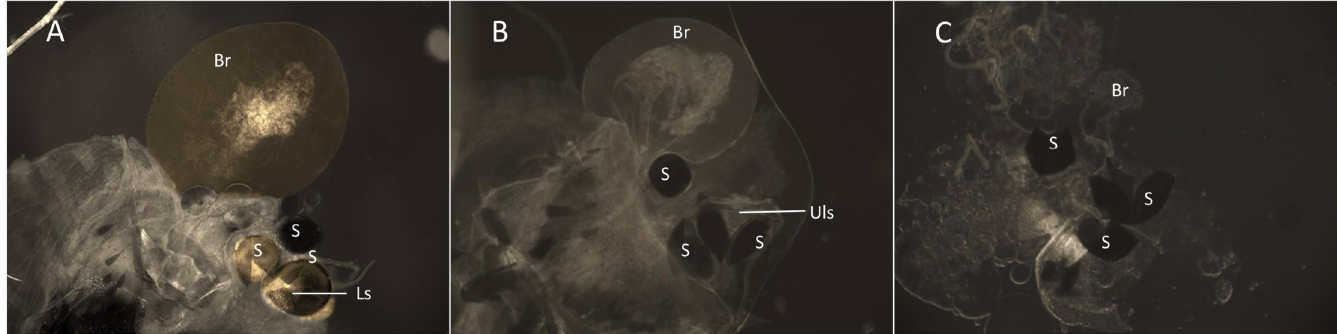
Fig 1. Examination of female spermathecae for Rho B stained sperm to confirm successful mating by Rho B marked males. (A) Staining of an expanded bursa (Br), spermathecae (S) and labelled sperm (Ls), indicating a successful mating event with a male marked with Rho B. (B) No staining in the spermathecae, unlabelled sperm (Uls) or bursa but the expanded bursa indicates a successful mating event with a non-Rho B-marked male. (C) Unmated virgin female, no sperm present in the spermathecae and the bursa is not expanded.